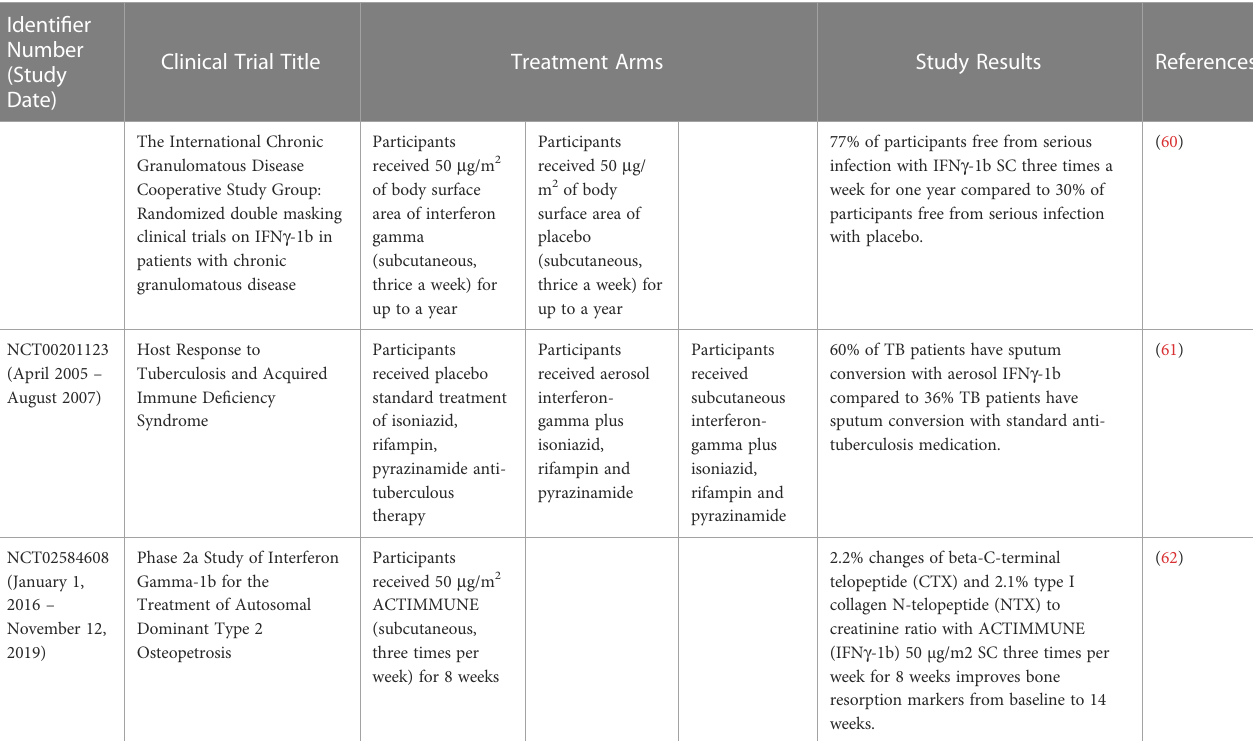
TABLE 3 Clinical trials of IFN- g and their